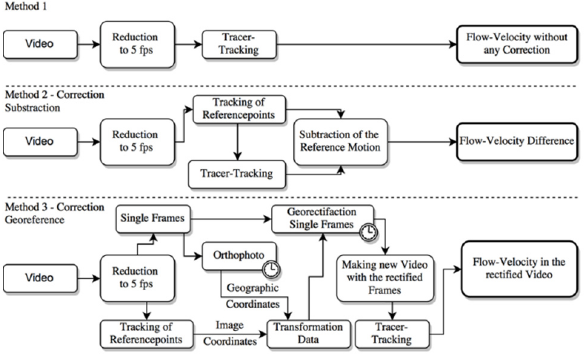
Figure 1 Workflows of three surface velocity determination